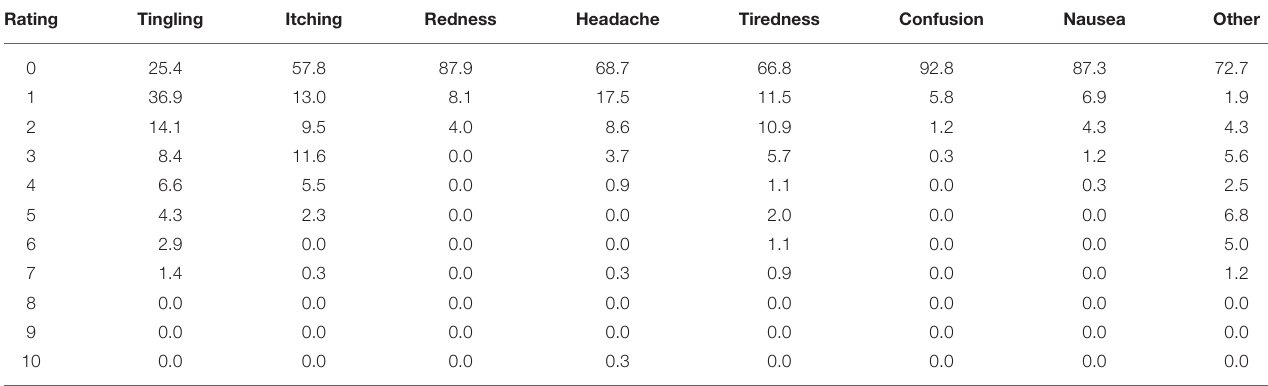
TABLE 1 | Group level distribution percentages of side effects rated at each intensity level for a total of 578 reported stimulation sessions. Rating Tingling Itching Redness Headache Tiredness Confusion Nausea